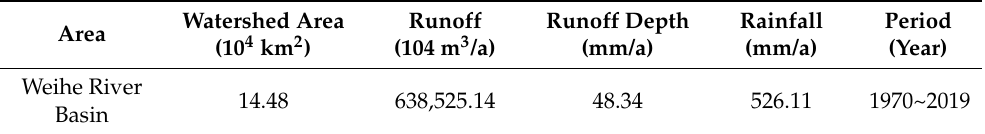
Table 2. Hydrological information of the Weihe River